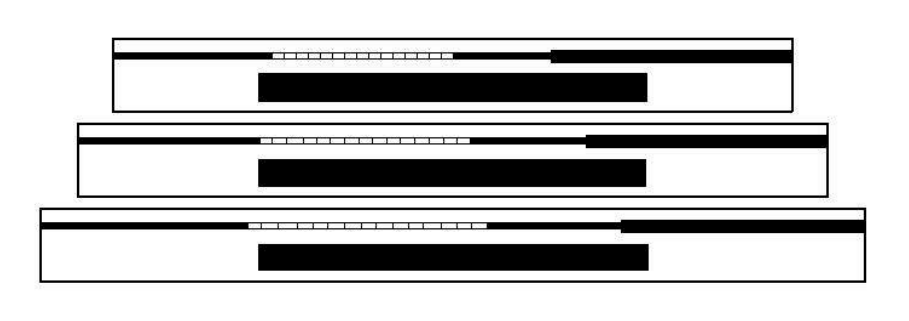
FIGURE 3. Schematic representation of the elastic N-filaments’ behavior in sarcomere during stretching; the central domains (white boxes) of N-filament keep approximately the same rapports with their neighboring thick